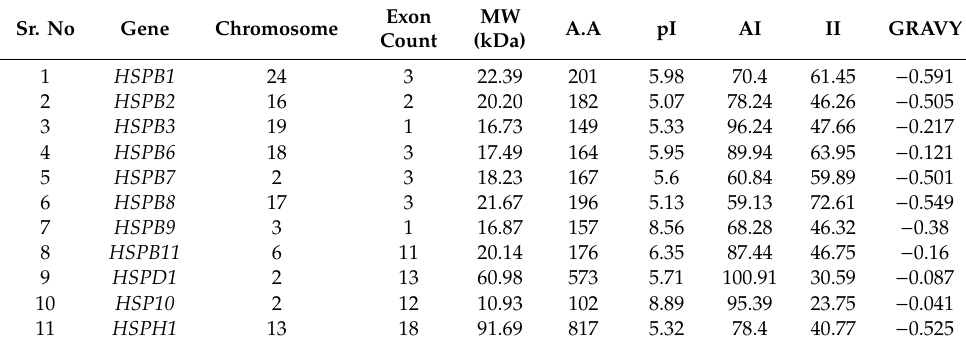
Table 3. Physiochemical Properties of HSP family B, HSP10 , HSPD , and HSPH1